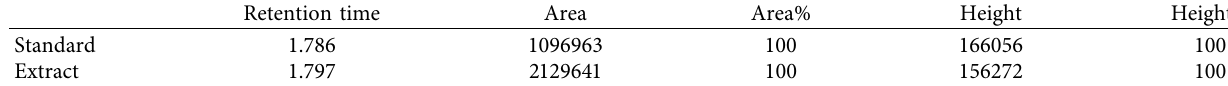
Table 1: HPLC data depicting the comparison of the standard and the extract.